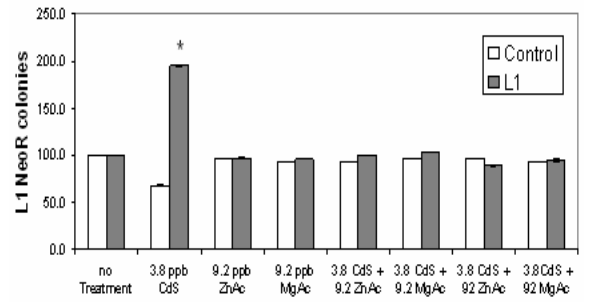
Figure 4 : Magnesium and zinc reverse the L1 stimulation induced by CdS exposure. Cells were transfected with the L1 retrotransposition vector and treated with an L1 stimulating CdS dose